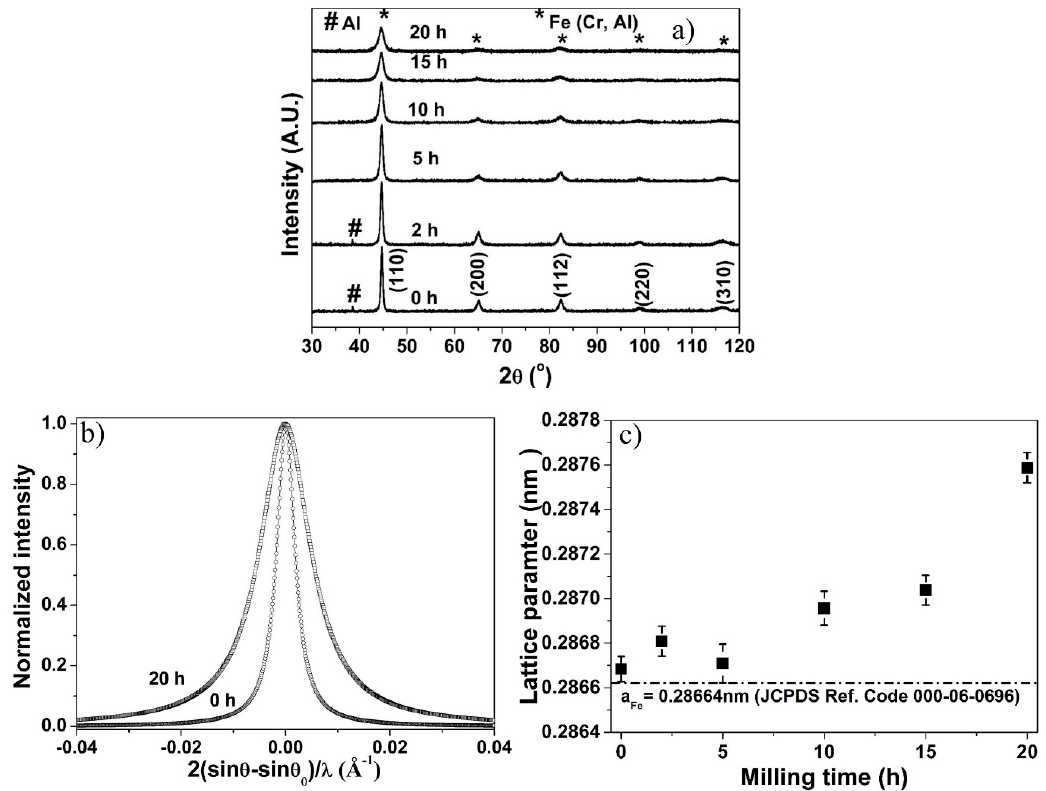
Figure 1. Effect of milling on ( a ) XRD patterns; ( b ) broadening of (110) peak after 0 h and 20 h of milling and ( c ) lattice parameter of Fe–10Cr–3Al alloy powder. Here, θ and θ o are diffraction and exact Bragg angles, respectively.